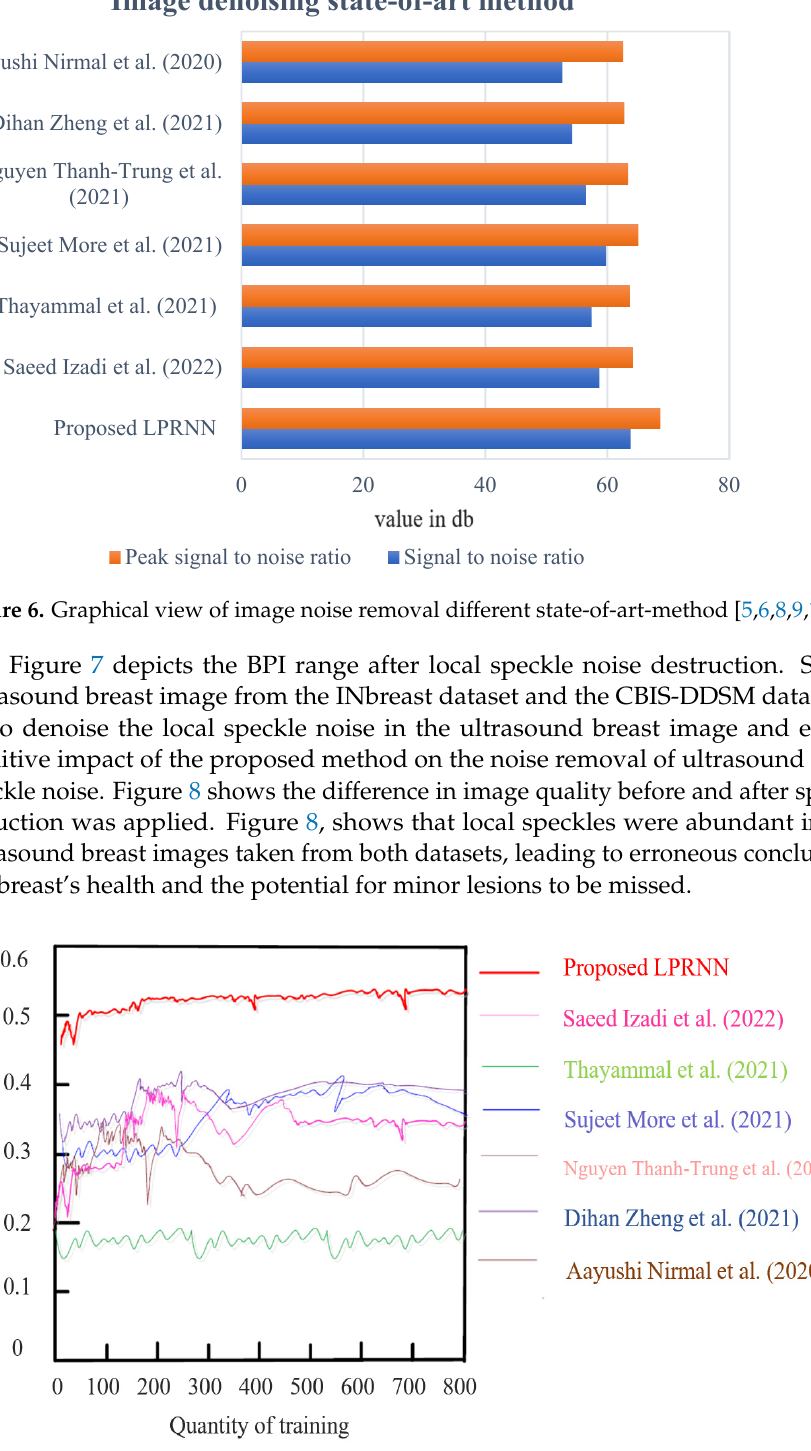
Figure 7. BPI after local speckle noise-removal [5,6,8,9,11,14].